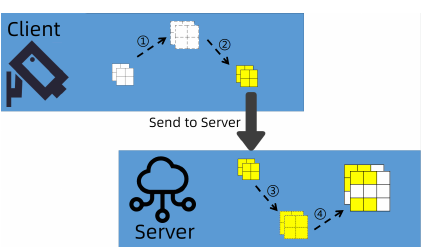
Figure 4. Client to Server. (1) The client decompresses and trains the compression model using local data, and (2) compresses the final local update. They send the local updates back to the central server, and (3) decompression is carried out by the central server, and (4) the global model is created through aggregation on the central